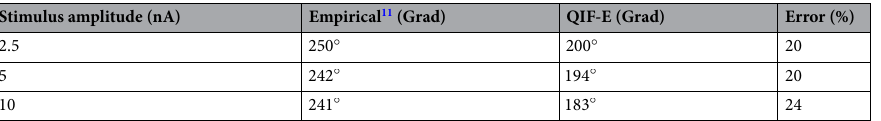
Table 3. Results of suprathreshold empirical population vector phases, and population vector phases obtained by the QIF-E model. The last column display the relative errors. Model data correspond to the configuration of 1 Hz, 10 dB.